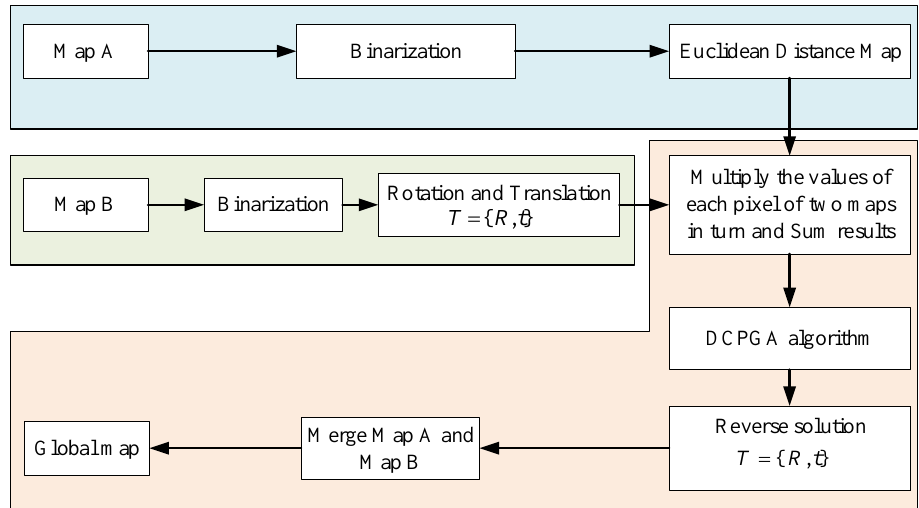
Figure 1. Map-merging frame based on DCPGA